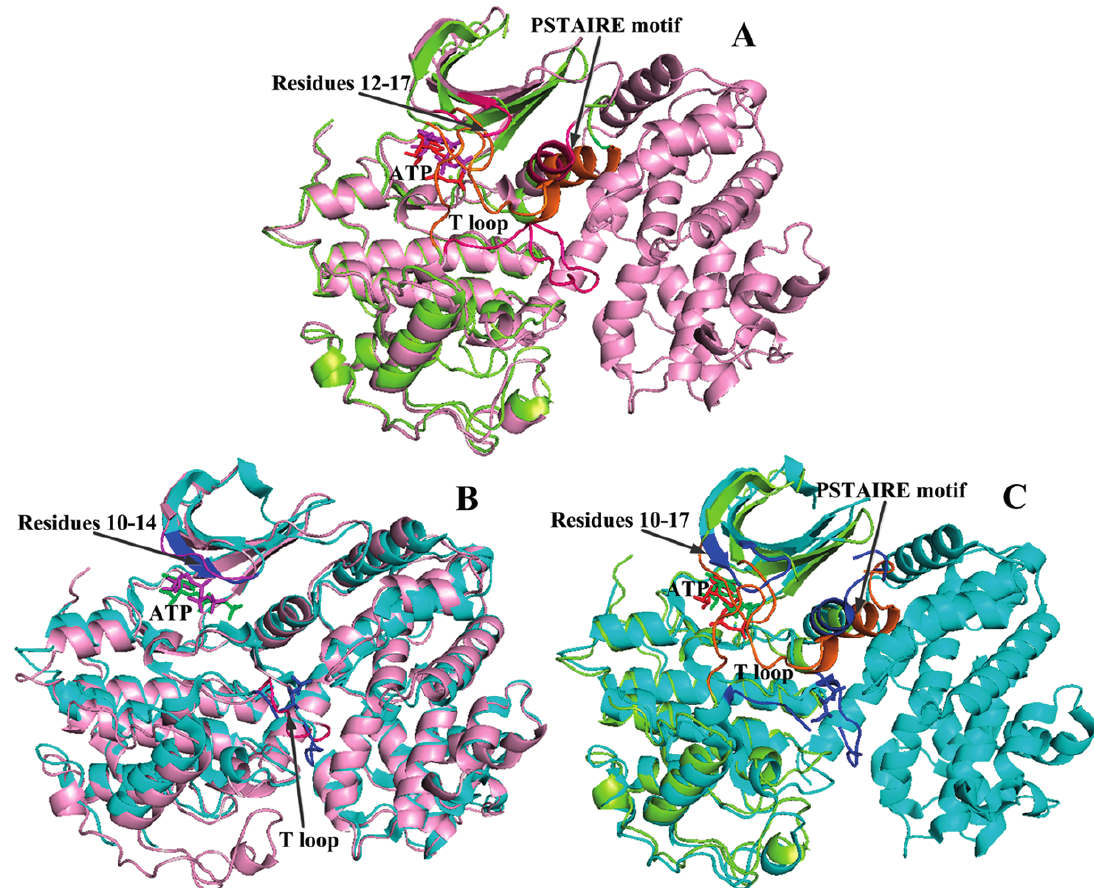
Figure 9. Comparison of the CDK2 conformation changes in free, partially and fully activated states. ( A ) Structural superposition of free and partially activated CDK2 complexes; ( B ) The alignment of partially and fully activated CDK2 complexes; ( C ) Structural superposition of free and fully activated CDK2 complexes. The yellow, pink and cyan patterns indicate the monomeric CDK2 (free state, coordinates 1HCK), CDK2/cyclin A complex (partially activated form, 1FIN) and phosphorylated dimer (fully activated state, 4EOM), respectively. The changed conformations of monomeric CDK2, CDK2/cyclin A complex and phosphorylated dimer are colored in orange, magenta and blue,